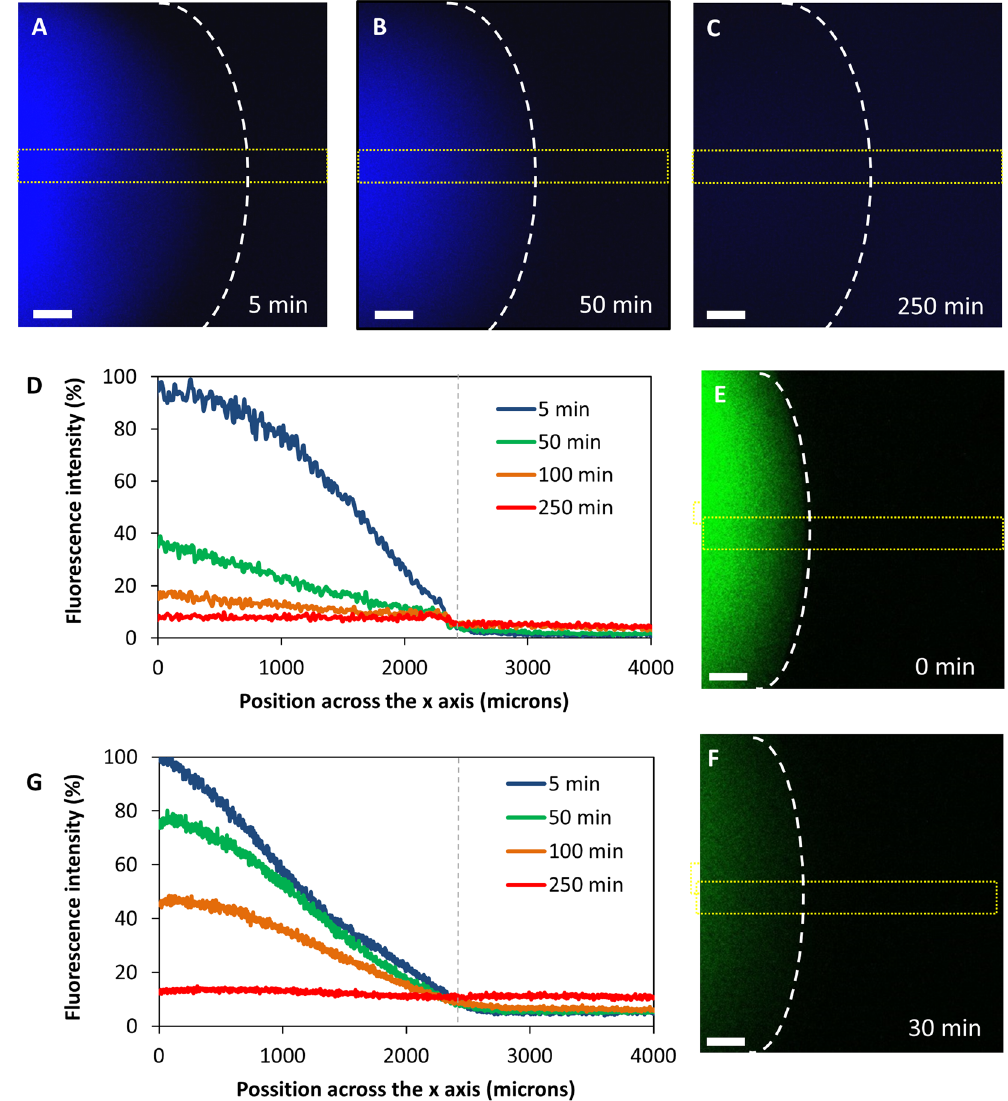
Figure 2. ( A–C ) Diffusion of Cascade Blue dextran (mean MW = 10 kDa) from an agarose spot at different time intervals time. The edge of the spot is shown by dotted white line. ( D ) Fluorescence intensity along a central strip of the agarose spot (shown as a dotted yellow line) at different time intervals. The edge of the spot is shown by dotted grey line. ( E and F ) Diffusion of Fluorescein dextran (mean MW = 40 kDa) from an agarose spot at 0 and 30 minutes time intervals. ( G ) Fluorescence intensity along a central strip of the agarose spot at different time intervals. The edge of the spot is shown by dotted grey